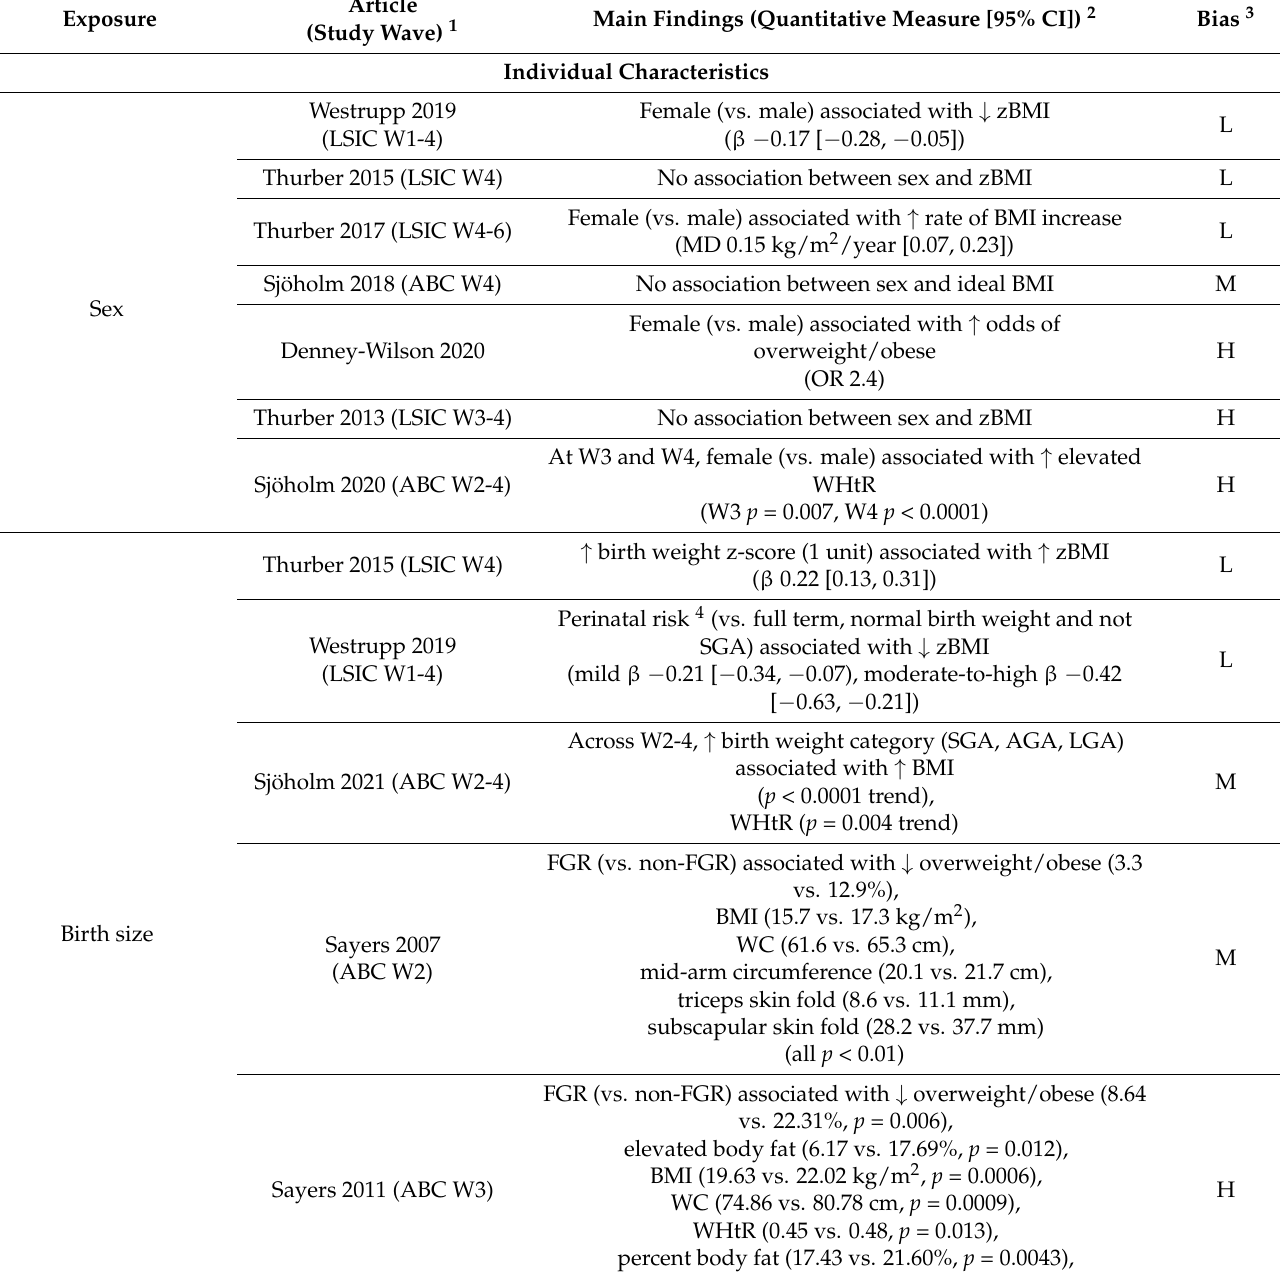
Table 4. Quantitative associations with obesity outcomes, arranged by exposure type and listed in order of lowest to highest risk of